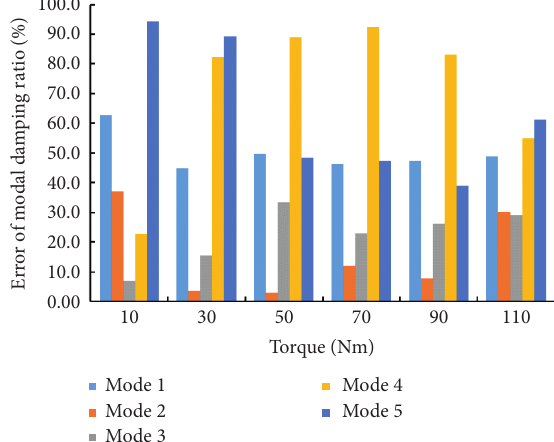
Figure 14: Error of modal damping ratio for five mode shapes using 1mm thin-layer element.